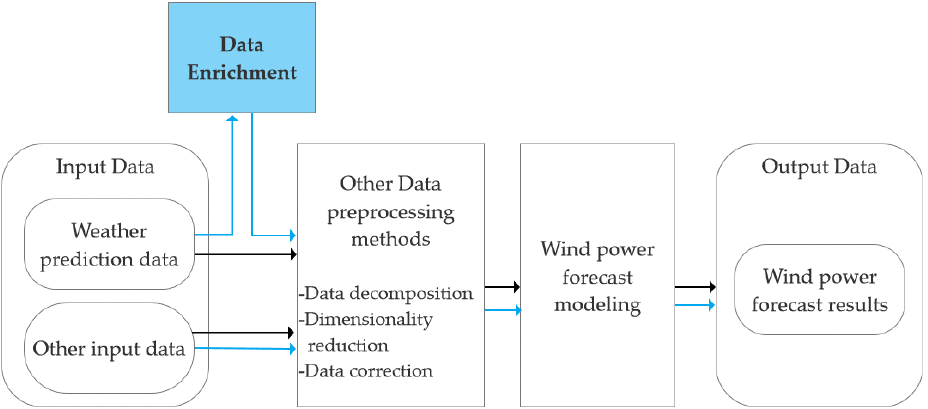
Figure 1. Illustration 1 of the relationship between the proposed data enrichment method, other incumbent data preprocessing methods, and wind power forecasting models. ( 1 The black lines represent the data flow without data enrichment; The blue lines represent the data flow with the proposed data enrichment method).